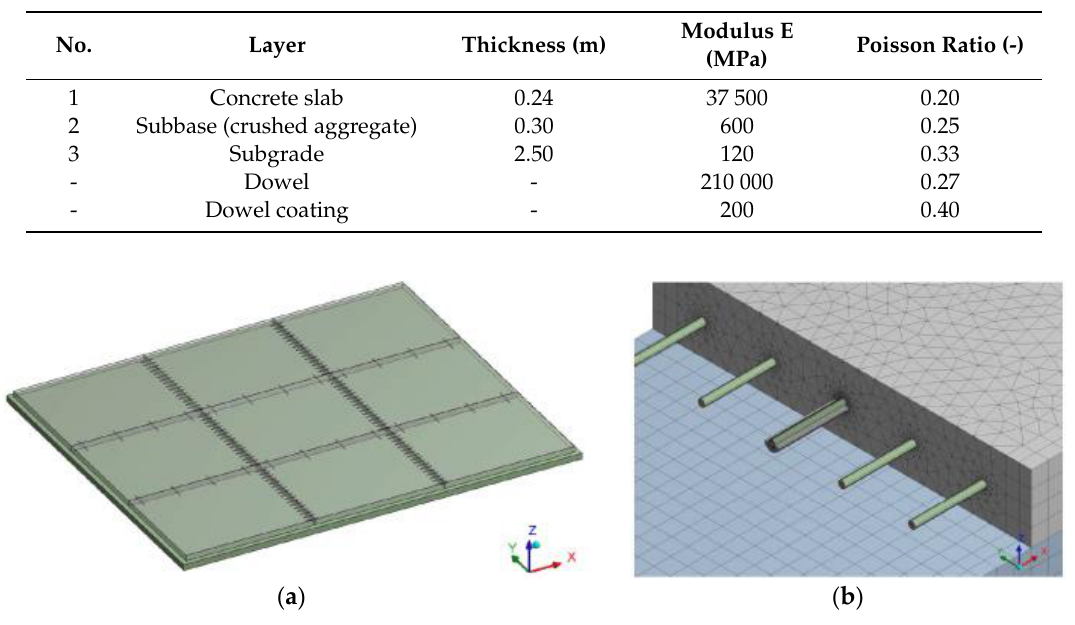
Figure 4. ( a ) Global; and ( b ) detailed numeric model.